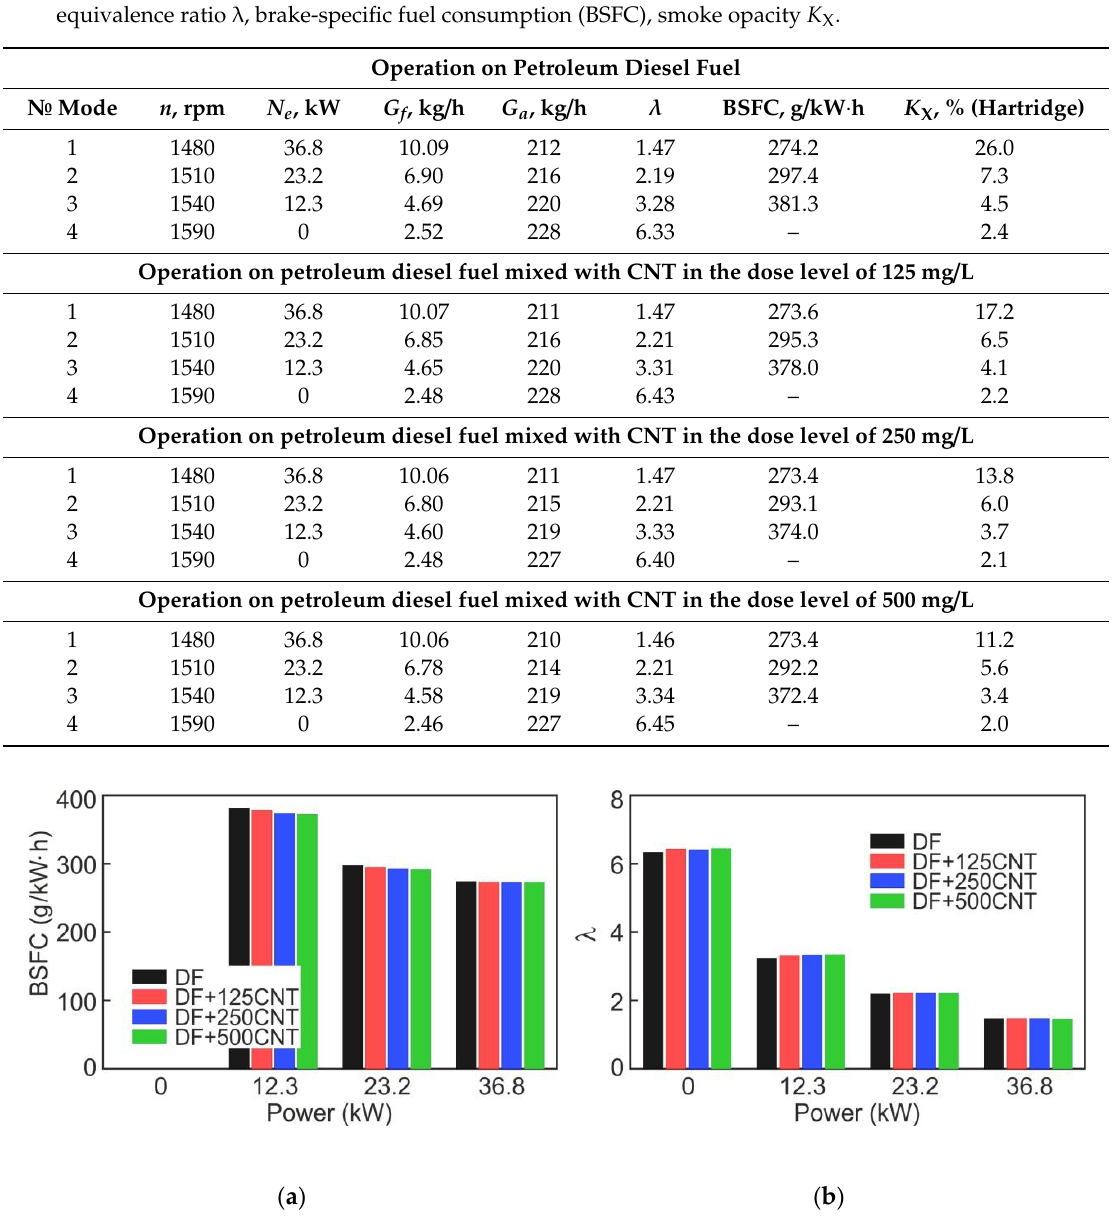
Table 3. Test results of D-243 diesel engine running according to the regulatory characteristic. Engine